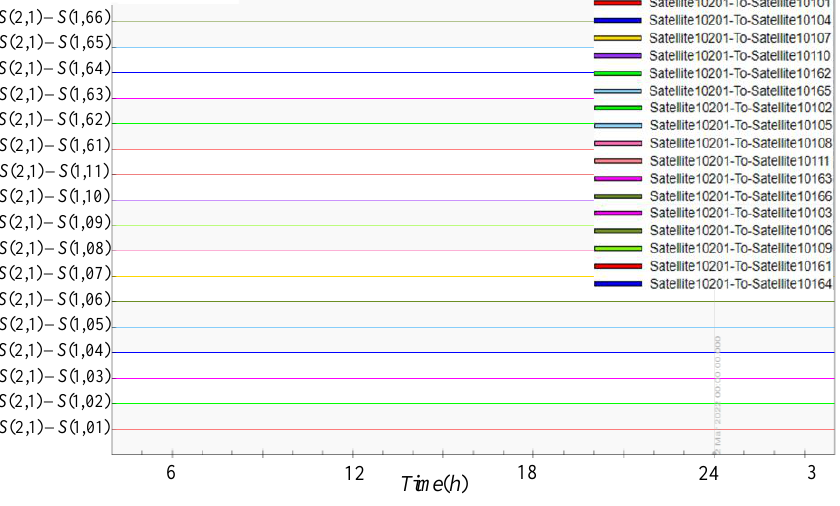
Figure 10. Visibility analysis of adjacent orbiting satellites.